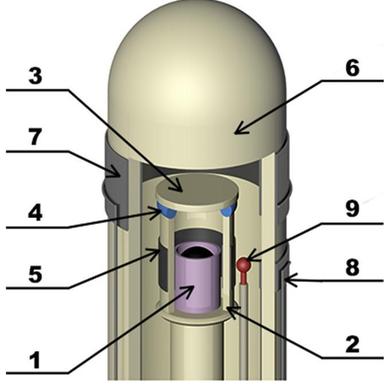
Experimental setup for coulometric titration measurements. 1- corundum liner with powdered sample, 2 e zirconia measuring cell, 3 e zirconia lid, 4 e hightemperature sealant, 5 e cell pump and sensor Pt electrodes, 6 e zirconia covering cell, 7 and 8 e deposited Pt electrodes for pumping and sensing oxygen pressure, 9 e thermocouple.